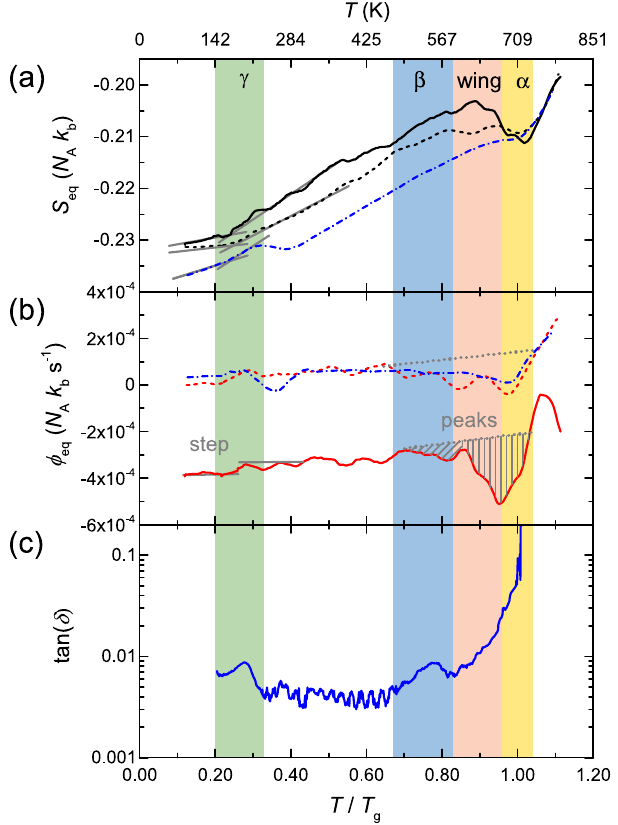
Fig. 3 Structure dynamics relationship. Derivation of the equivalent con fi gurational heat fl ow (shown in ( b )) from the equivalent con fi gurational entropy (shown in ( a )). (dashed line) HPT at 77K, (full line) HPT at RT, (dash- dotted line) as-cast. A change of slope at the γ -transition is indicated by solid gray lines in ( a ). Considerable enthalpic relaxation (the peaks are indicated by dashed gray lines in ( b )) occurs when entering the β -relaxation region and between β and α in the excess wing region. c Displays the loss tangent tan( δ ) as determined from torsion geometry DMA of the as-cast material.